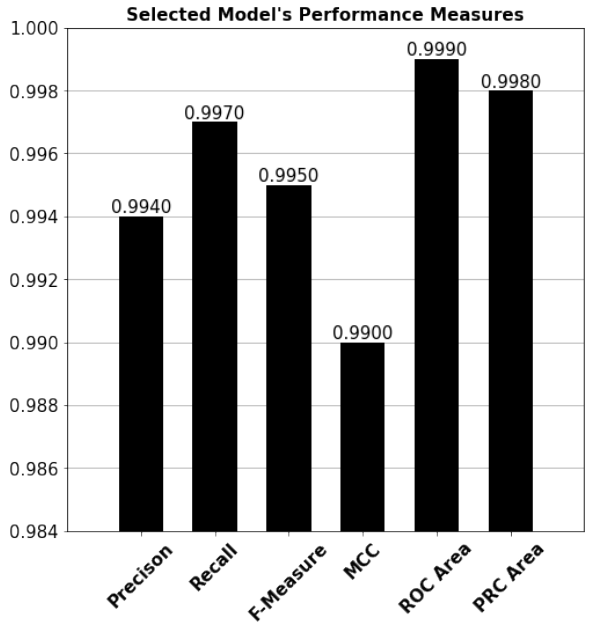
Figure 8. Performance of the selected